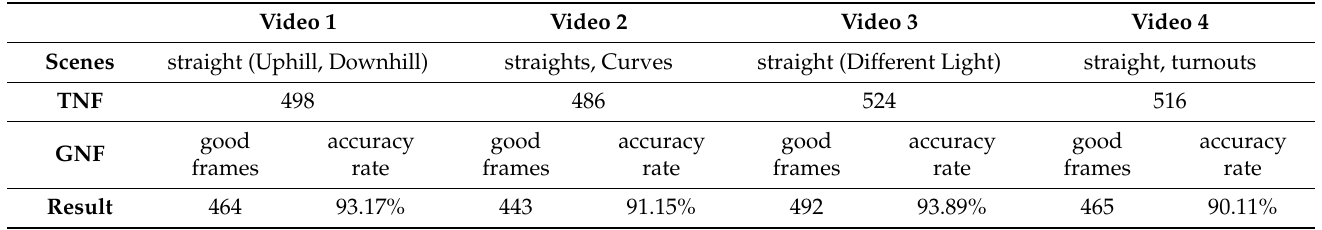
Table 4 The results of the comparative experiment under subway tunnel conditions scenario.